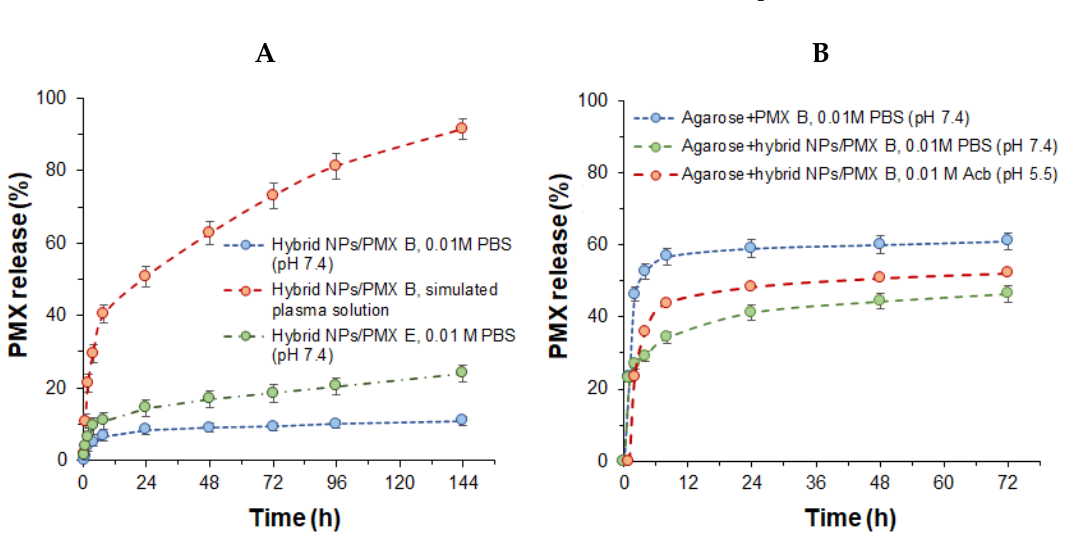
Figure 10. Release of polymyxin E and B over time from hybrid PGlu@Ag nanoparticles ( A ) and polymyxin B from composite hydrogels ( B ).